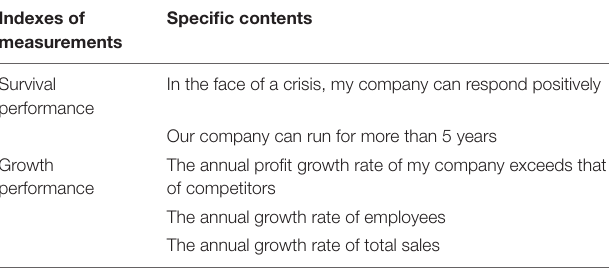
TABLE 3 | Core issues of the QS for the entrepreneurial performance (EP) of college entrepreneurs.